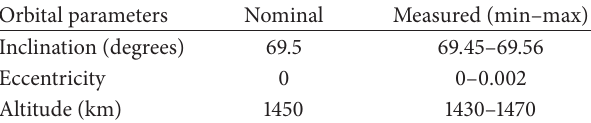
Table 1: LARES orbital